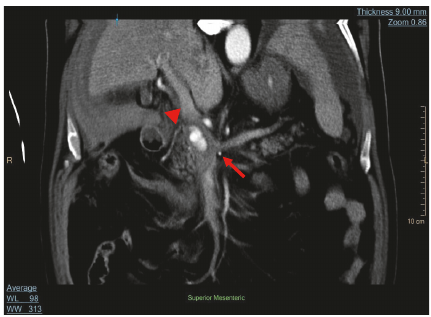
Figure3: Coronalreconstructionrevealingpatentportalvein(Arrow- head) with compression of confluence by the aneurysm : filling of the aneurysm with contrast is shown with its respective compression on the confluence of the superior mesenteric vein and the portal vein (Arrow)